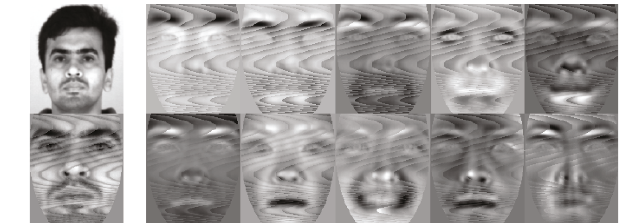
Figure 9: One sample spectral-face and the first 10 spectral eigenfaces.